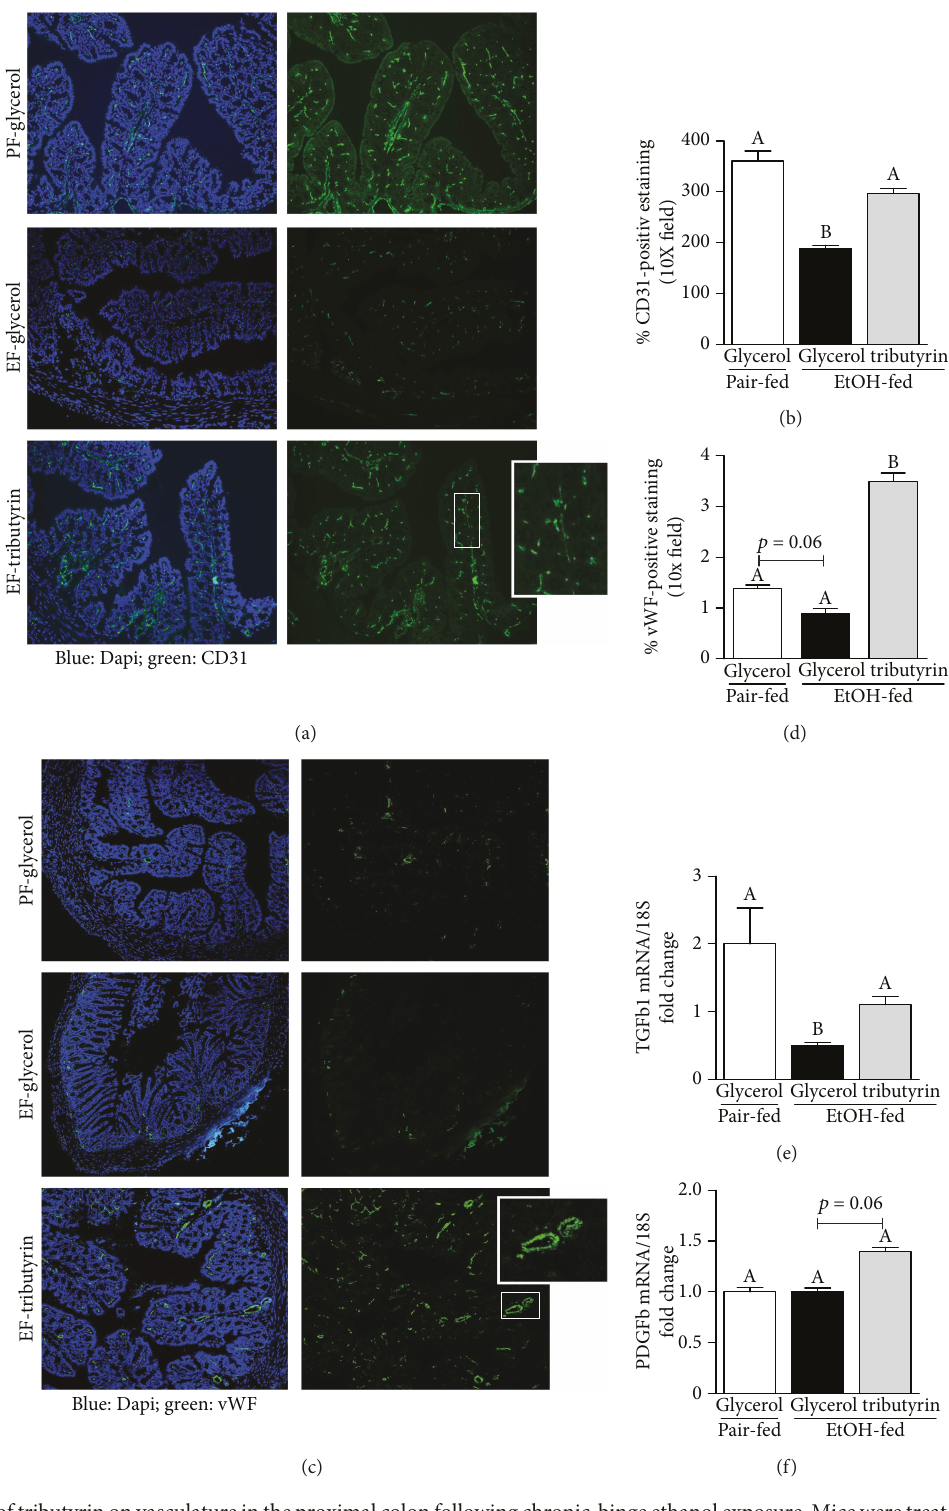
Figure 5: E ff ect of tributyrin on vasculature in the proximal colon following chronic-binge ethanol exposure. Mice were treated as described in Figure 1, and the proximal colon was excised and used to prepare RNA or embedded in OCT for histology. (a) CD31 (green) and (c) vWF (green) were visualized by immunohistochemistry in sections of proximal colon frozen in OCT. All images were acquired using a 10x objective. A selected area was cropped and enlarged. Images are representative of at least replicate images captured per mouse in four to six mice per treatment group. (b, d) CD31- and vWF-positive areas were quanti fi ed using Image Pro Plus software and analyzed. (e, f) Expression of TGF β 1 and PDGFb mRNA was detected in the proximal colon using quantitative real-time reverse transcription polymerase chain reaction. Data are mean ± SEM . Values with di ff erent alphabetical superscripts were signi fi cantly di ff erent from each other, p < 0 05